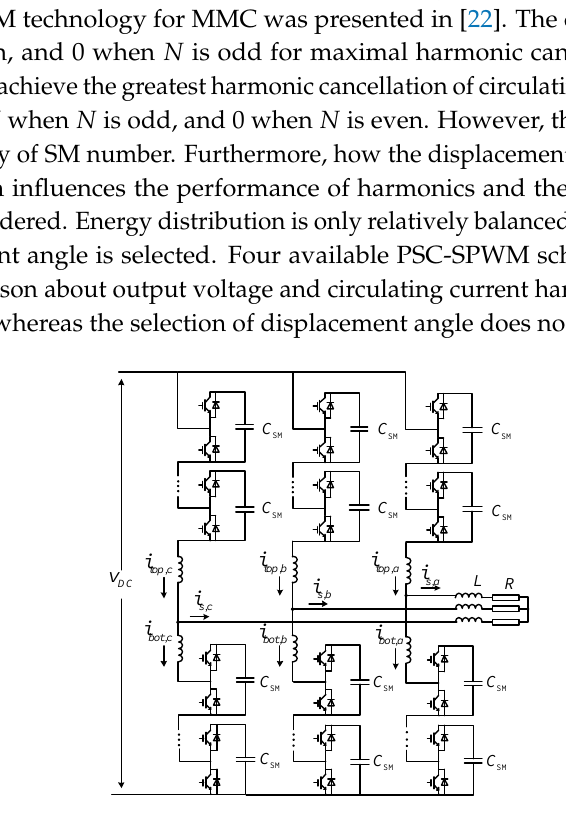
Figure 1. Structure of three-phase modular multilevel converter